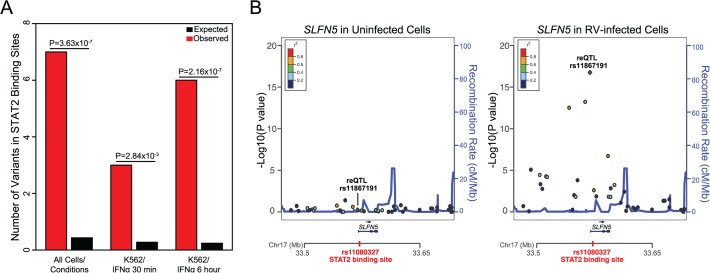
STAT2 binding sites are enriched among reQTL loci.
(A) Observed and expected numbers of variants that lie within STAT2 binding sites i) across all human cell types/conditions available in ENCODE ChIP-Seq data, ii) in IFNα-30 minute treated human K562 cell line, iii) in IFNα-6 hour treated human K562 cell line. (B) Regional eQTL association plots of SLFN5 in uninfected and RV-infected cells. See S6 Fig for regional eQTL association plots of the remaining four genes with significant reQTL loci SNPs that reside in STAT2 binding sites. In all five cases, the eQTL association was significant only in RV-infected cells.